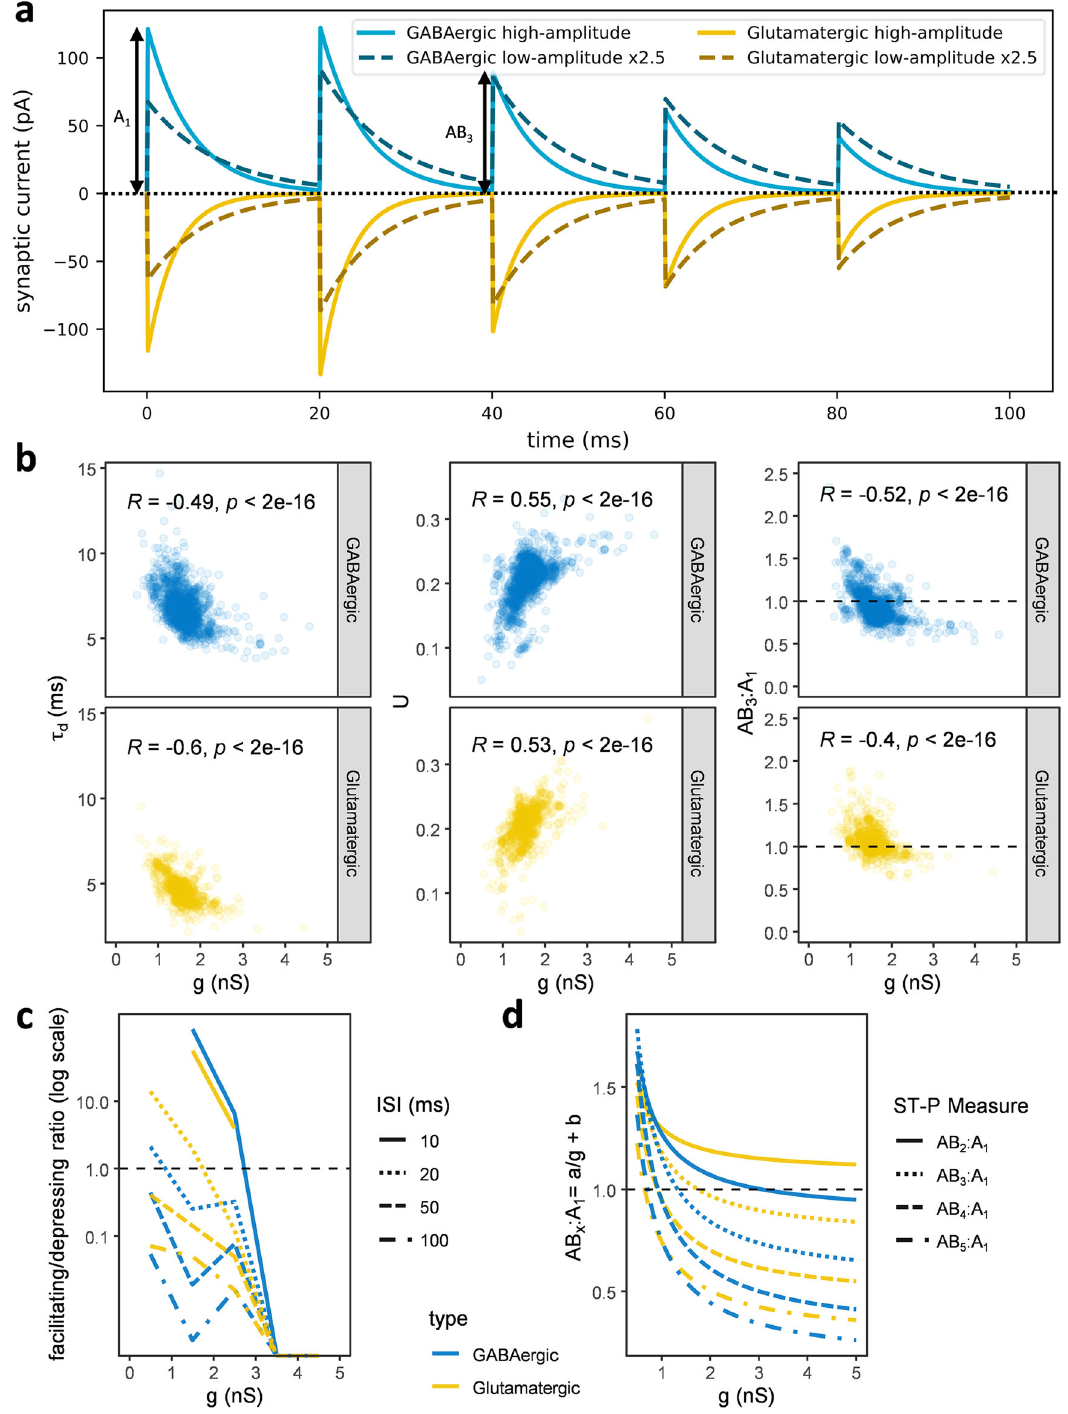
Fig. 7 Synaptic conductance entails kinetics and short-term plasticity. a We averaged the synaptic parameters of the 30 potential connections with the largest conductance (high-amplitude) and of the 30 with the smallest one (low-amplitude) to compare their simulated consensus signals. The low- and high-amplitude groups exhibited respectively short-term facilitation and depression (ISI = 20 ms, V h = − 35 mV, GABA A E rev = − 70 mV, and AMPA E rev = 0 mV). A 1 is the synaptic amplitude of the fi rst event; AB 3 is the amplitude from the baseline of the third event. b Considering all connections, synaptic amplitude correlates with kinetics and short-term plasticity (ST-P). The negative correlation between g and τ d (left) indicates that synapses with large conductance tend to have faster signal decays. The positive correlation between g and U (middle) suggests that high-amplitude synapses have higher resource utilization. The negative correlation between g and the ratio from the baseline of the third event, AB 3 :A 1 , (right) shows that high-amplitude synapses depress more. c The ratio between facilitation (AB 3 :A 1 > 1) and depression (AB 3 :A 1 ≤ 1) decreases as a function of conductance with a transition from mainly facilitating to mainly depressing between 1 nS (GABAergic) and 1.7 nS (glutamatergic) for 20 ms ISI. d Fitting the dependence on g of the ratio from the baseline of the x th event, AB x :A1, with an inverse fi rst-order polynomial function reveals that earlier synaptic events (e.g., AB 2 :A 1 ) tend to facilitate while later ones (e.g., AB 5 :A 1 ) tend to depress. The trend from facilitation to depression with increasing conductance is robust to ST-P